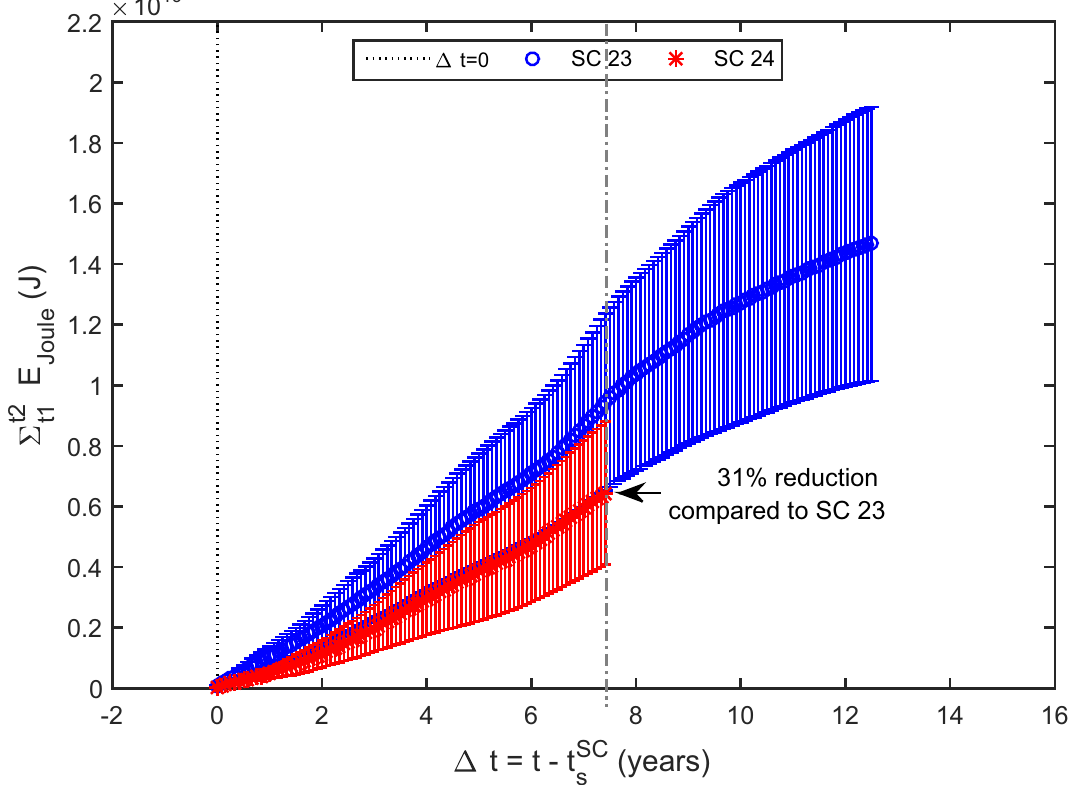
Fig. 8. Deposition of Joule energies at high latitude as SC progresses is shown for SC 23 (blue), and SC 24 (red). D t = 0 represents the start time for both SCs. 31% reduction is seen in the high latitude Joule energy deposition for SC 24 as compared to that for SC23. The energy deposited during SC 22 is not plotted because of data gap in AE during 1988–1990.